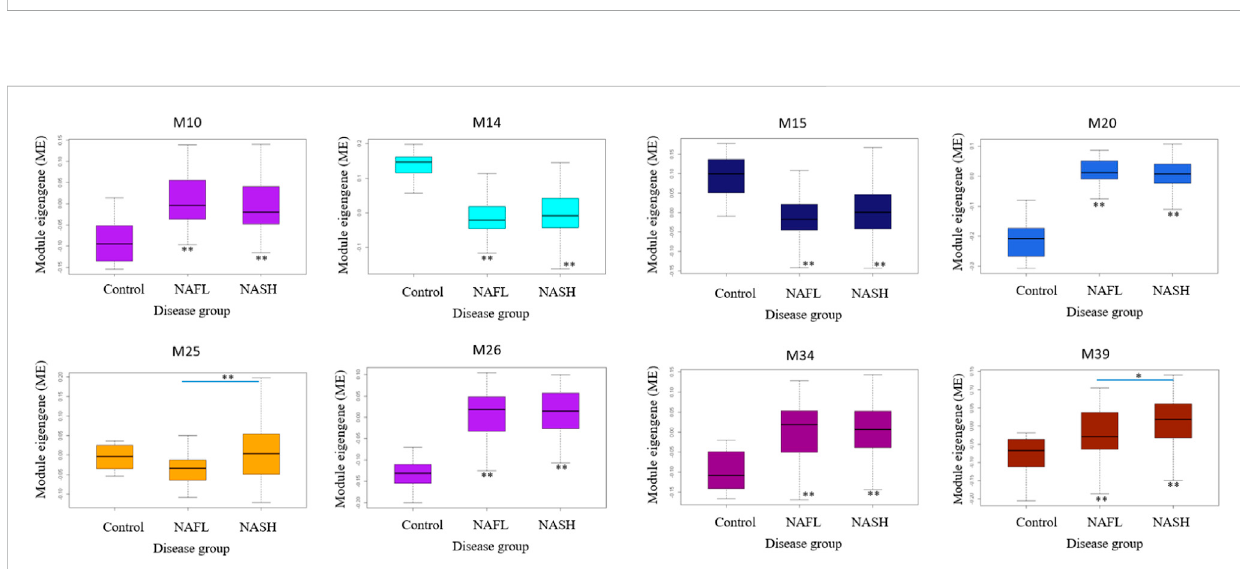
FIGURE 7 Differentially expressed modules associated with NAFLD disease stages in GSE135251. The asterisk under the box indicates the signi fi cance of the comparison between disease and normal control by ANOVA test with adjusted p values. *: p < 0.05, **: p < 0.01.